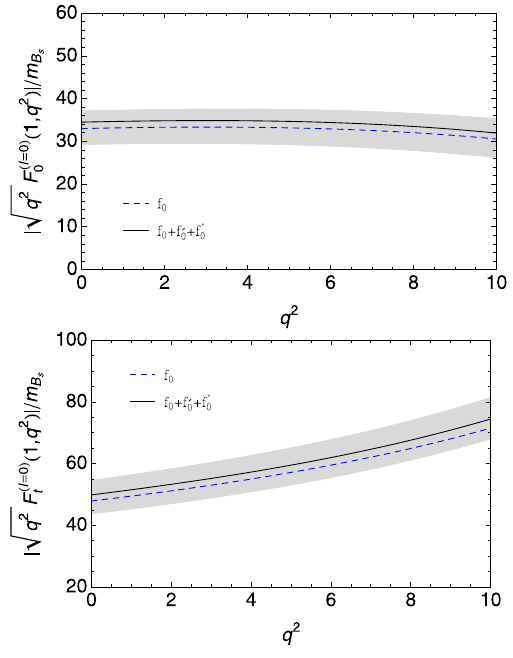
(cid:22) q 2 F ( l = 0 ) t ( 1 , q 2 )/ m B